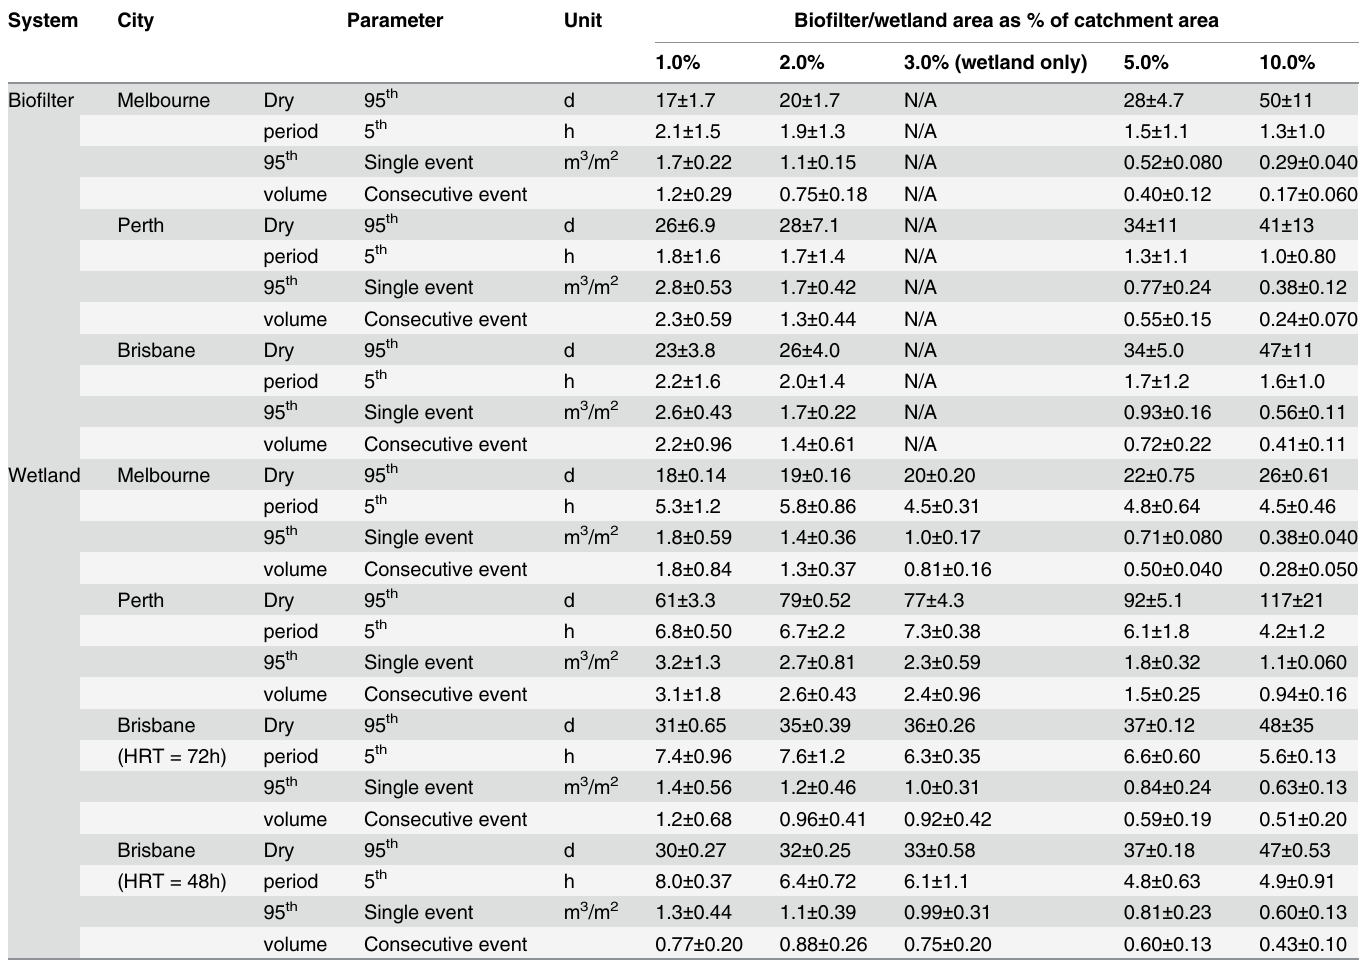
Table 6. Estimated average values ( ± standard deviation) of different operational variable at different system